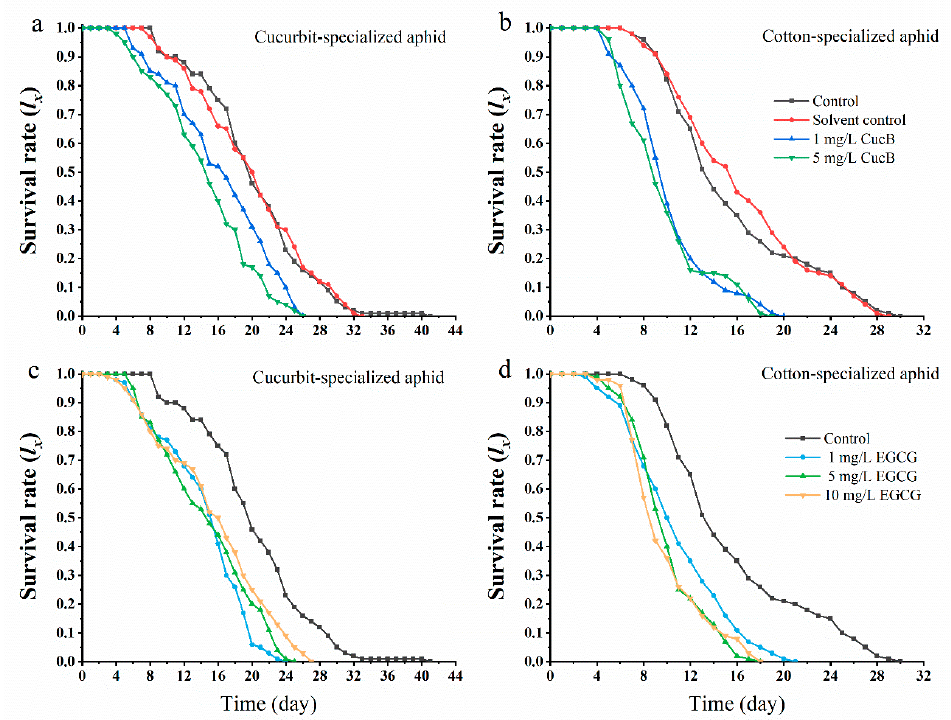
Figure 1. Survival rate ( l x ) of Aphis gossypii exposed to Cucurbitacin B (CucB) and epigallocatechin gallate (EGCG). ( a ): CUS exposed to CucB; ( b ): COS exposed to CucB; ( c ): CUS exposed to EGCG; ( d ): COS exposed to EGCG.